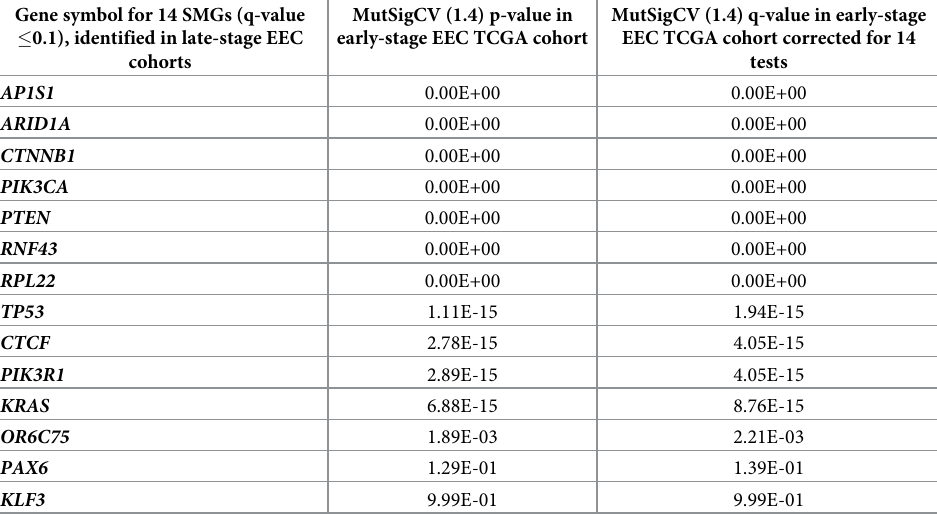
Table 3. PAX6 and KLF3 are the only late-stage EEC SMGs (q-value � 0.1) that are not statistically significantly mutated in early-stage EEC. Gene symbol for 14 SMGs (q-value � 0.1), identified in late-stage EEC cohorts